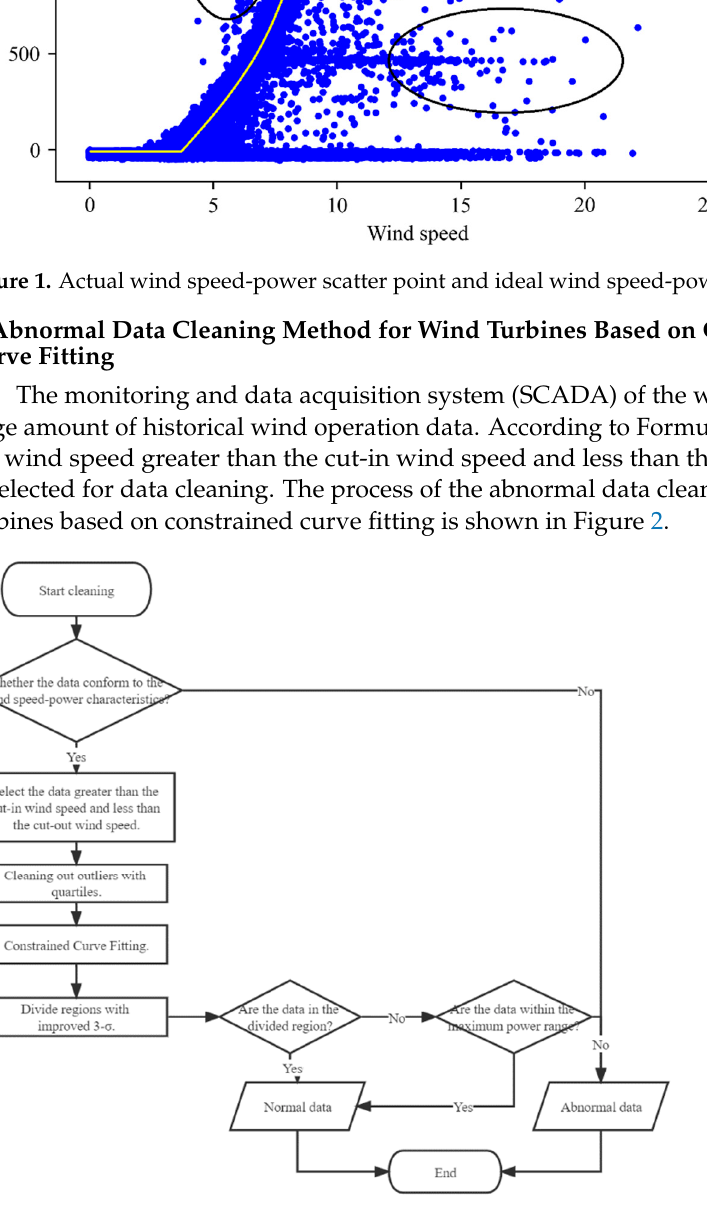
Figure 2. The process of the abnormal data cleaning method for wind turbines based on constrained curve